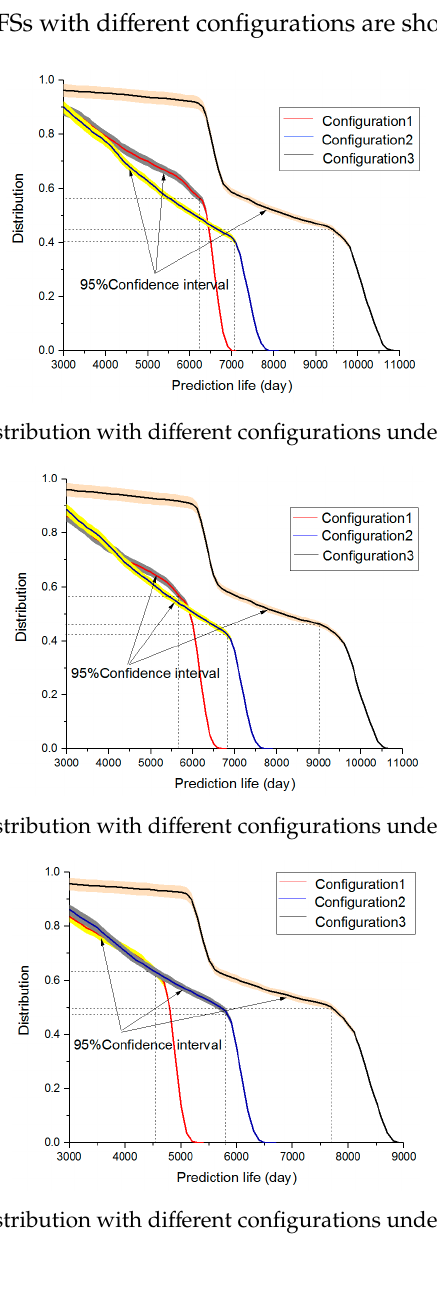
Figure 20. Life distribution with different configurations under work mode M3.